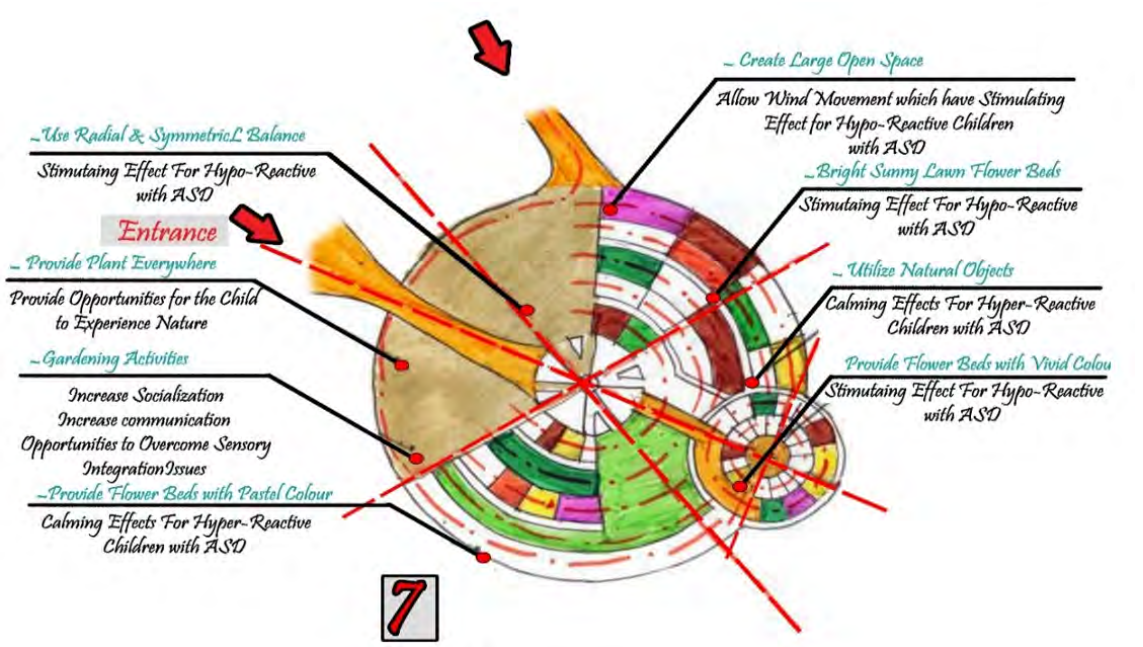
Figure 25. Shows the design consideration for the gardening